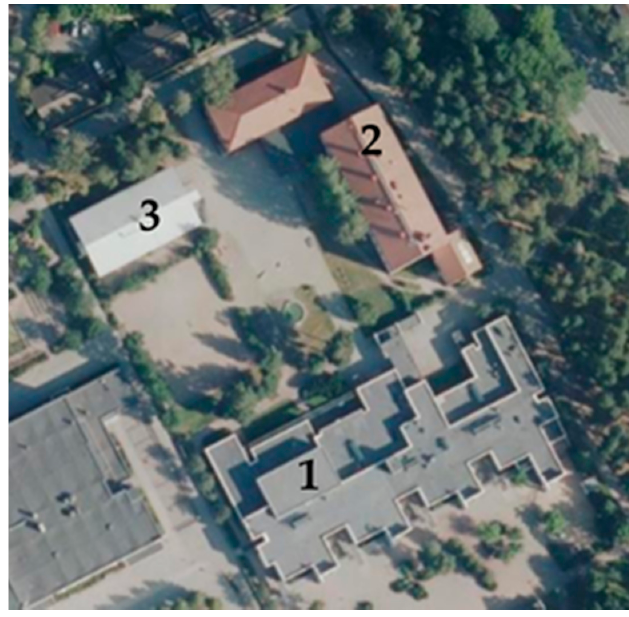
Table 2. The participants of the meetings.